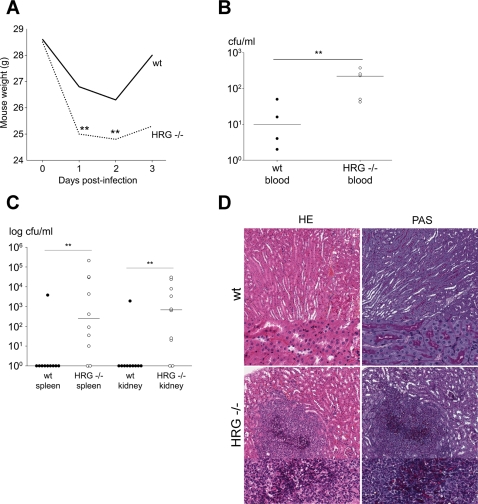
Candida produces severe infection in Hrg−/− mice.(A) Weight loss in mice after infection with C.albicans. C57BL/6 (solid line) and C57BL/6 Hrg−/− (dotted line) mice were infected (i.p.) with 1×109 cfu of C. albicans, and the body weight was followed from day 0 to day 3 (n = 6,4 and 2, respectively) (p = 0.02). (B) Fungal dissemination to the bloodstream. C57BL/6 (•) (n = 4) and C57BL/6 Hrg−/− (○) (n = 5) mice were infected as above and the animals were sacrificed on day 2 and number of cfu in blood was determined (p = 0.032). (C) HRG suppresses fungal dissemination to the spleen and kidney. C57BL/6 (•) and C57BL/6 Hrg−/− (○) mice were infected as above and the cfu of C. parapsilosis in spleen and kidney was determined (p = 0.009, n = 10) (D) In two animals kidneys were collected on day 3, fixed, sectioned and then stained with hematoxylin and eosin (HE) (left panel) or PAS (right panel) (upper section; magnification ×10 and lower section; magnification ×30).